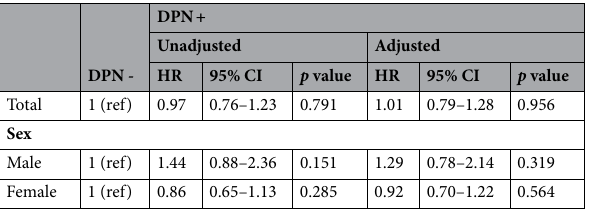
Table 4. Unadjusted and Adjusted Hazard Ratio for CTS release according DPN presence in participants with CTS and DM.